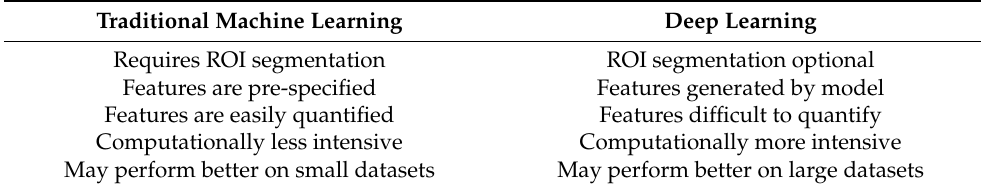
Table 2. Possible benefits and limitations of traditional ML vs. deep